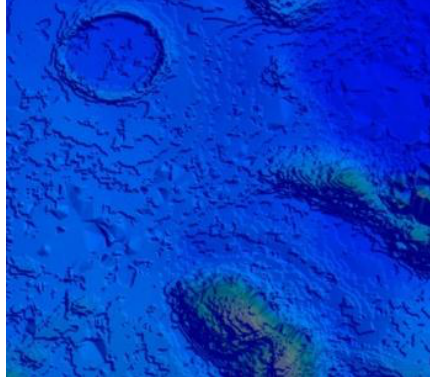
Figure 7. DEM results of